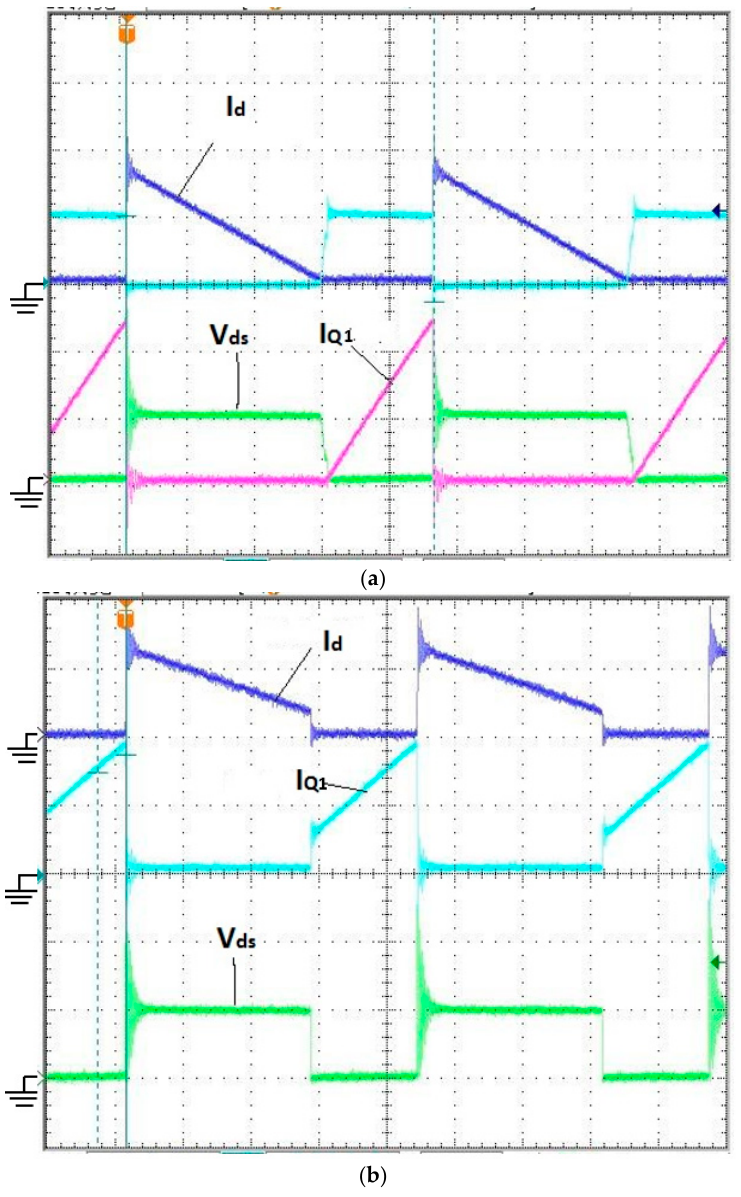
Figure 10. ( a ) A conventional QR-mode operation waveform, I o = 5.26 A ( I d : 10 A / div, I Q 200 V / div, time: 4 µ s /div), and ( b ) A conventional QR-mode and continuous conduction mode (CCM) operation waveform, I o = 5.26 A ( I d : 10 A / div, I Q